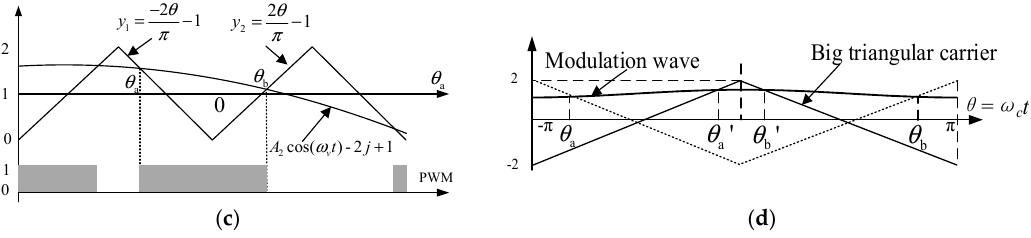
Figure 4. Double coordinate system. ( a ) Intersections between carrier and modulation waves of phase opposition disposition SPWM. ( b ) Intersections between carrier and modulation wave of carrier phase shifted SPWM. ( c ) Details of carrier and modulation wave of case ② . ( d ) Details of carrier and modulation wave of case ④ .